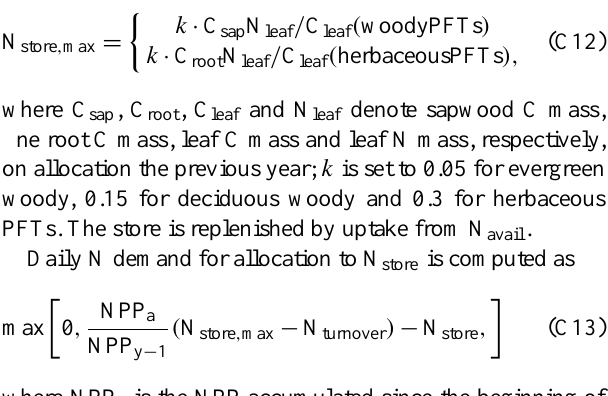
Table C1. C:N ratios and base (maximum) decay rates for soil and litter organic matter